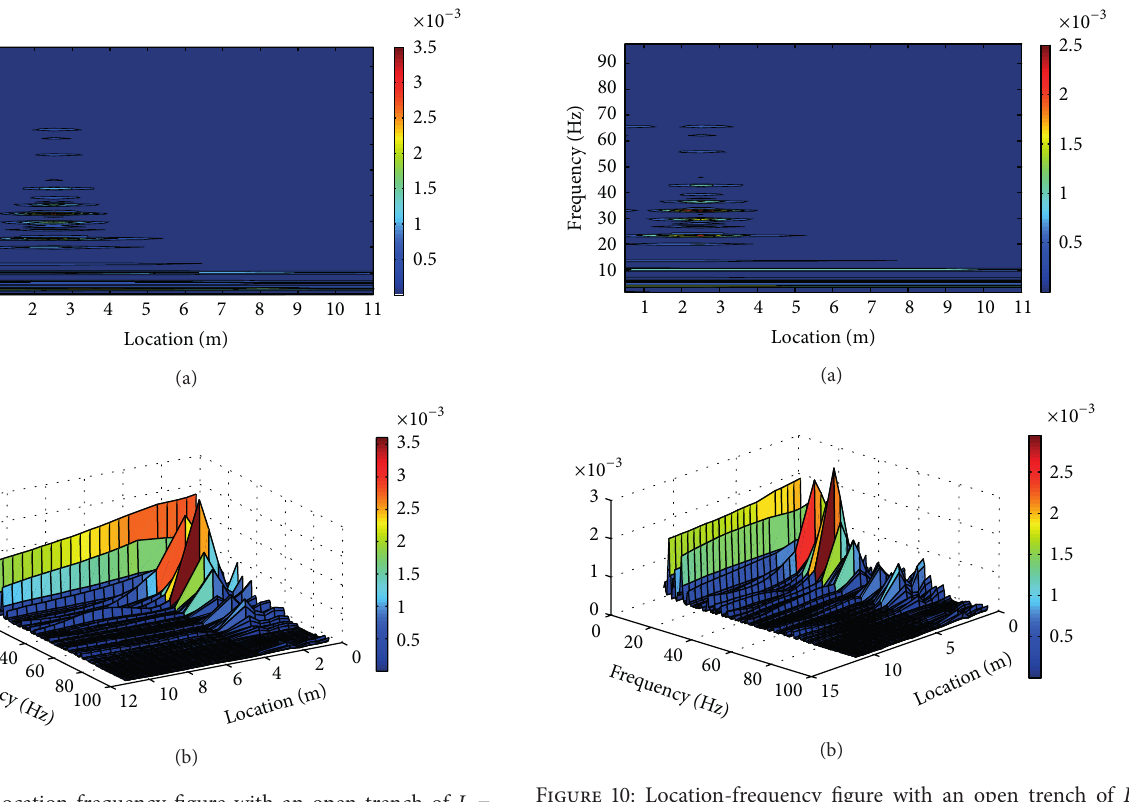
Figure 9: Location-frequency figure with an open trench of 𝐿 = 10m, 𝑊 = 1m, 𝐻 = 3m (a) contour plot of displacement spectrum on ground surface and (b) surface plot of displacement spectrum on ground surface (Poisson’s ratio ] = 0.25; train speed 𝑉 = 300 km/h). Note: the location coordinate of trench is from 2.5 to 3.5 m.